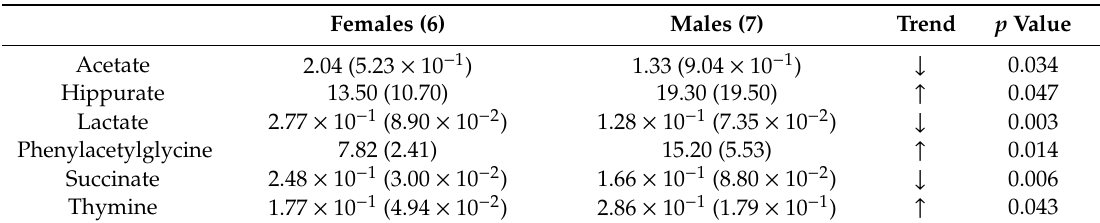
Table 1. Metabolite concentrations (mmol/L, median (IQR)) in the adult group were significantly ( p < 0.05) affected by sex, as assessed by t-test.